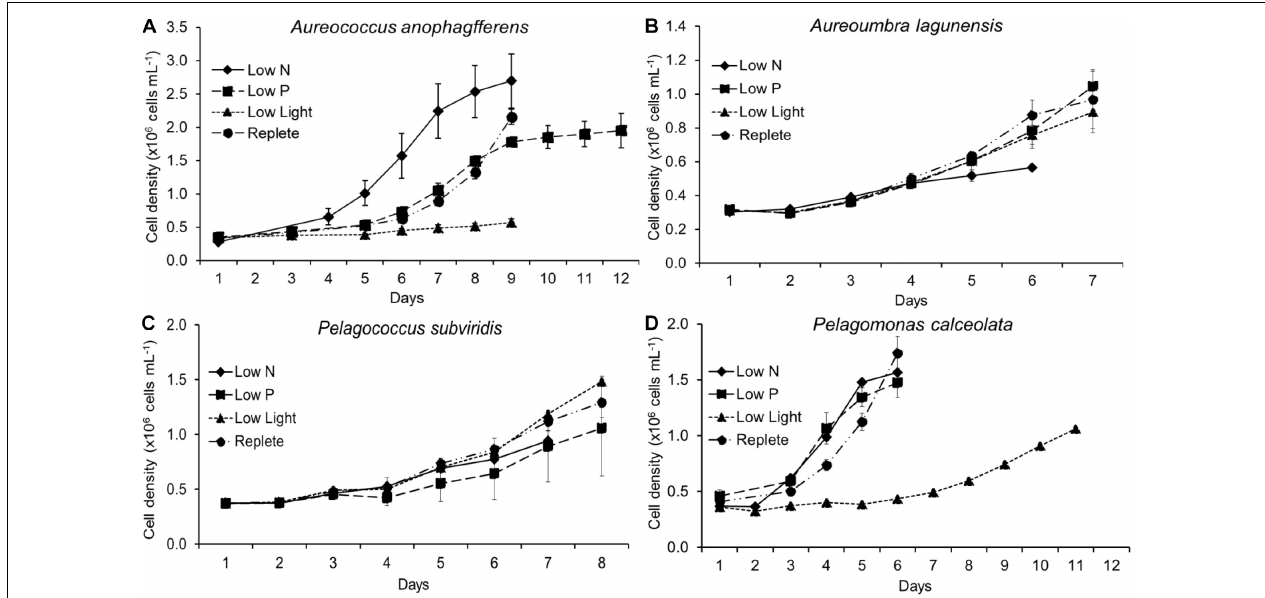
FIGURE 1 | Cell density during experiments. Cells from each treatment and each species were harvested at different times indicated by the last time point of each line. Aureococcus anophagefferens data have been previously reported in Frischkorn et al. (2014). (A) cell density of Aureococcus anophagefferens, (B) cell density of Aureoumbra lagunensis , (C) cell density of Pelagococcus subviridis , (D) cell density of Pelagomonas calceolata